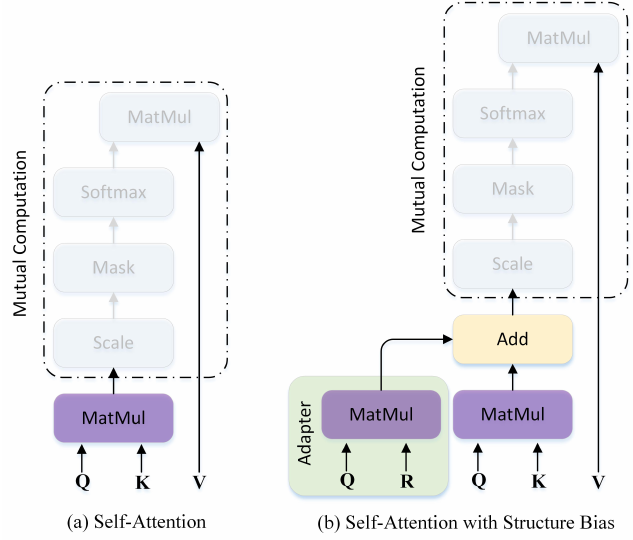
Figure 3. The mechanism of structure bias utilized in BERT. Furthermore, Q , K , and V denote the query vector, key vector, and value vector, respectively, which are standardized inputs for the transformer module. R indicates the relation distance embedding (Equation